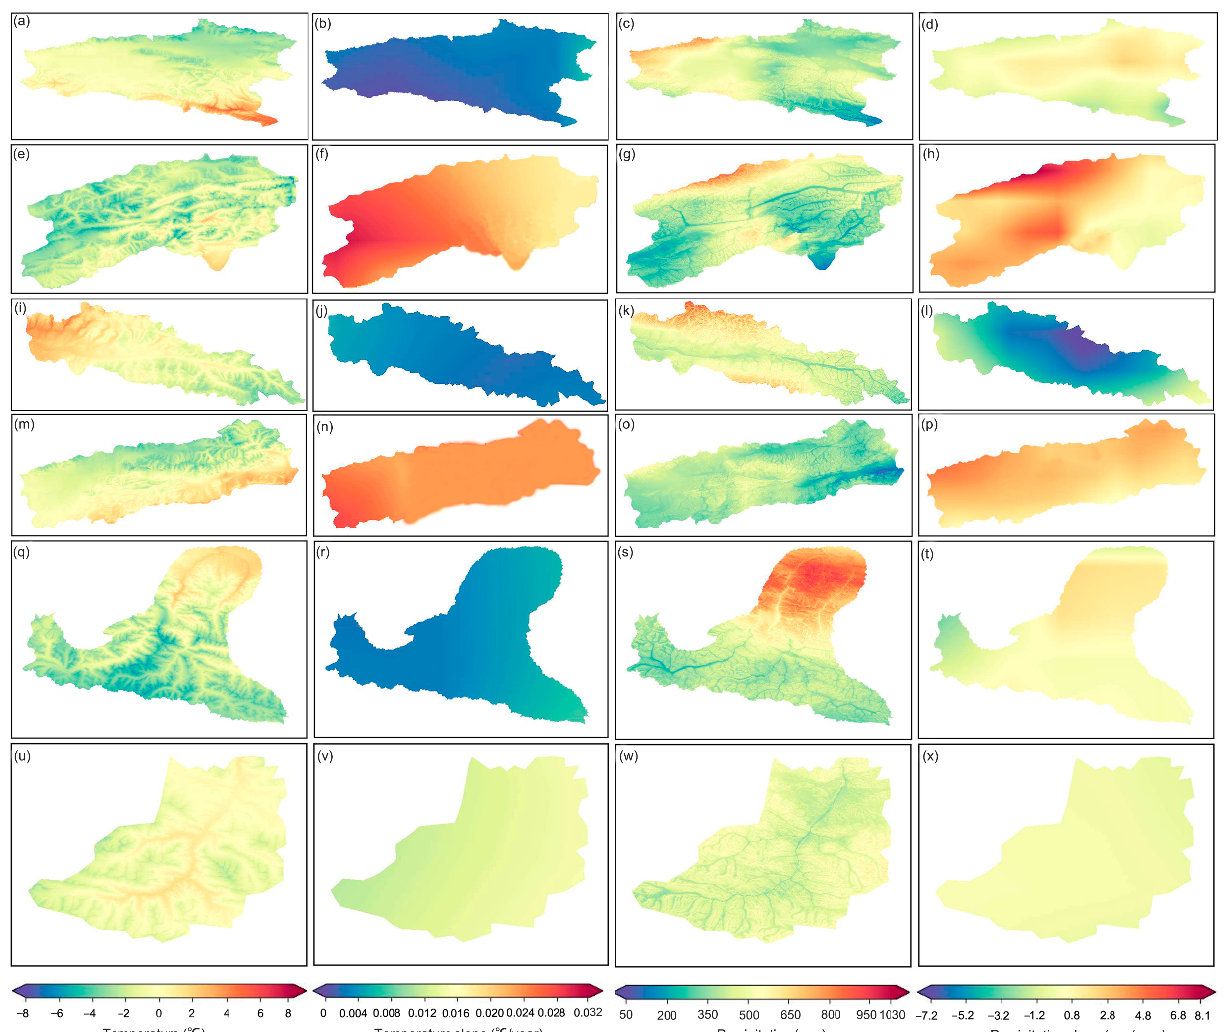
Figure 2. ( a – d ), spatial patterns and trends of precipitation and temperature from 1979 to 2020 in KRB; ( e – h ) KuRB; ( i – l ) KaRB; ( m – p ) TRB; ( q – t ) MRB; and ( u – x ) URB; ( a , e , i , m , q , u ) are annual average temperature; ( b , f , j , n , r , v ) are temperature trend; ( c , g , k , o , s , w ) are annual precipitation; ( d , h , l , p , t , x ) are precipitation trend.